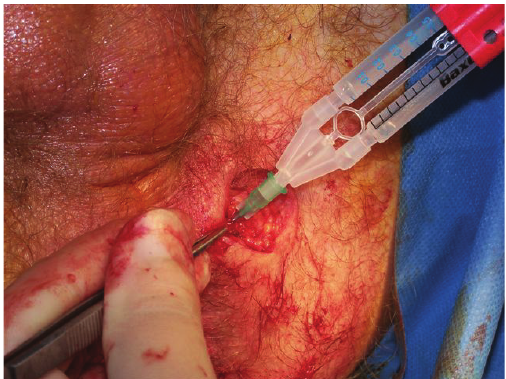
Figure 4: Injection of fibrin sealant injection (FS) after the seton was removed and curetted with a sharp